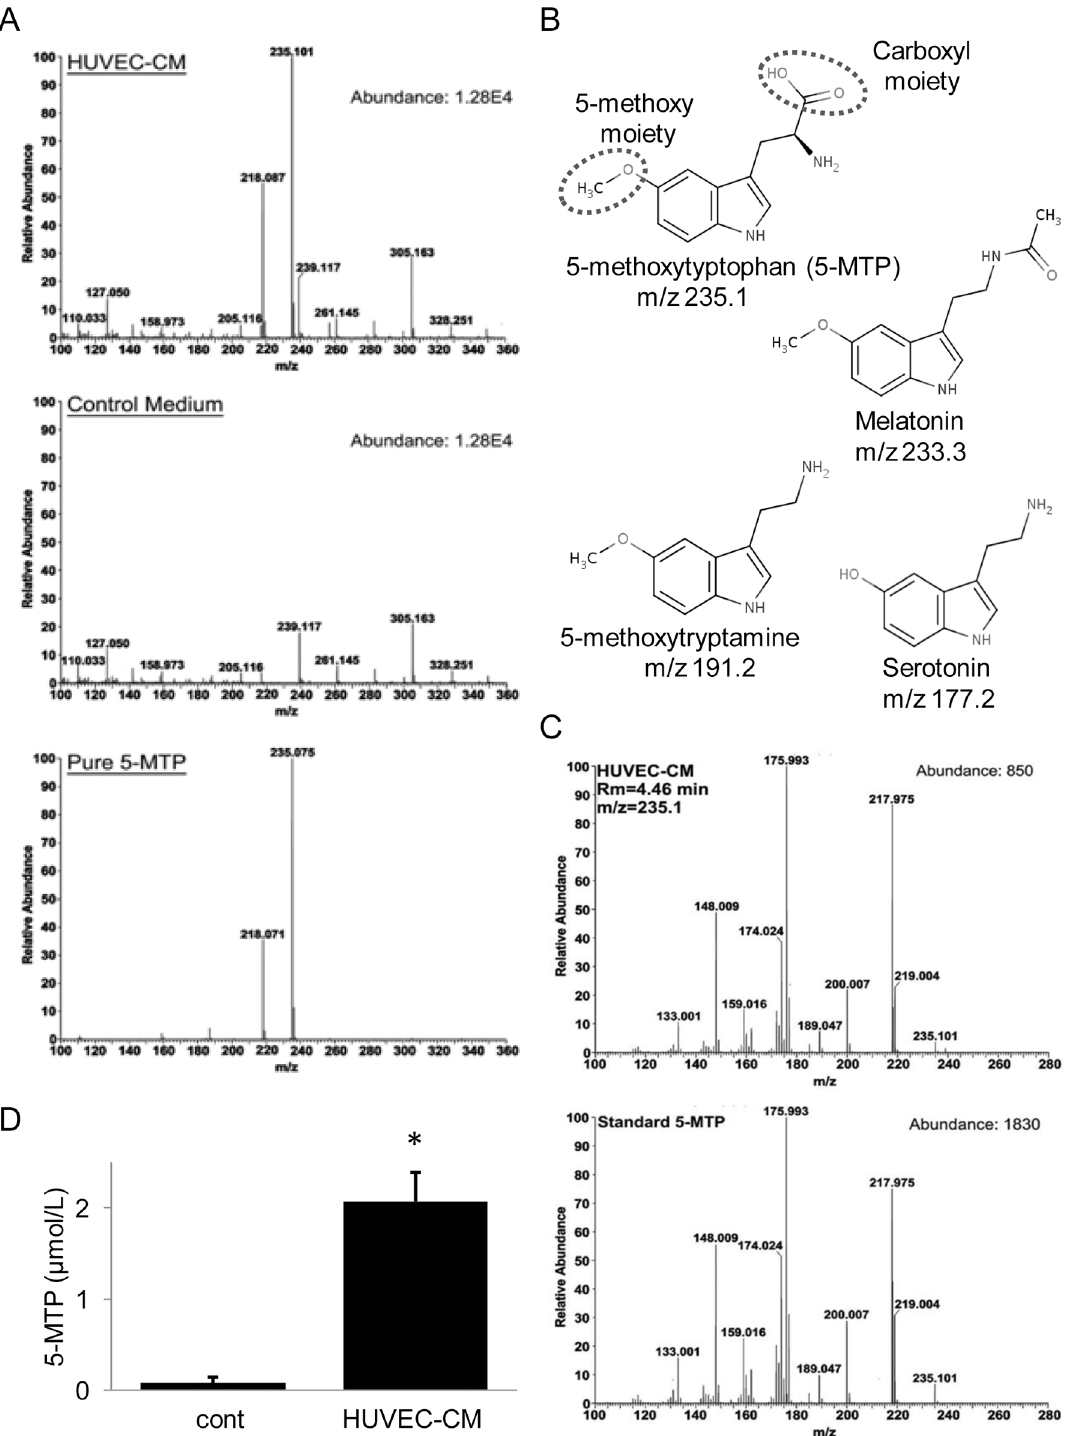
Fig 3. Endothelial cells release 5-MTP. (A) Comparison of single mass spectra of HUVEC-CM vs. control medium and pure 5-MTP by UPLC-QTof MS. (B) Comparison of the chemical structure of 5-MTP with that of major 5-HTP metabolites. The dashed circles depict the active groups of 5-MTP. Melatonin (N- acetyl 5-methoxytryptamine) possesses 5-methoxy but not the carboxyl group due to decarboxylation. It has weak anti-COX2 action. 5-methoxytryptamine, a major catabolic product of melatonin, is inactive. Serotonin (5-hydroxytryptamine) is also inactive. (C) Analysis of daughters of the m/z 235.1 peak in HUVEC-CM vs. that of pure 5-MTP by LC-MS-MS. (D) Measurement of 5-MTP in HUVEC-CM by ELISA. “ cont ” denotes control medium. * indicates P < .05.